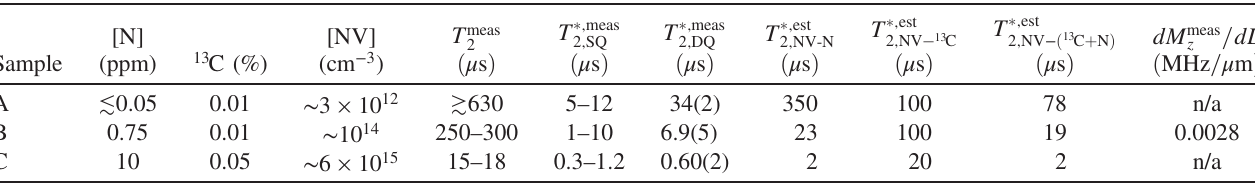
TABLE I. Characteristics of samples A, B, and C. The estimated values T (cid:1) ; est 2 are calculated using the contributions of 13 C and nitrogen spins as described in the main text. Reasonable agreement is found between the estimated T (cid:1) ; est consistent with the twice faster dephasing in the DQ basis. Values listed with a ∼ symbol are order-of-magnitude estimates. For all samples, ½ NV (cid:5) ≪ ½ N (cid:5) and NV contributions to T (cid:1) 2 can be neglected ( 1 ppm ¼ 1 . 76 × 10 17 cm − 3 ).